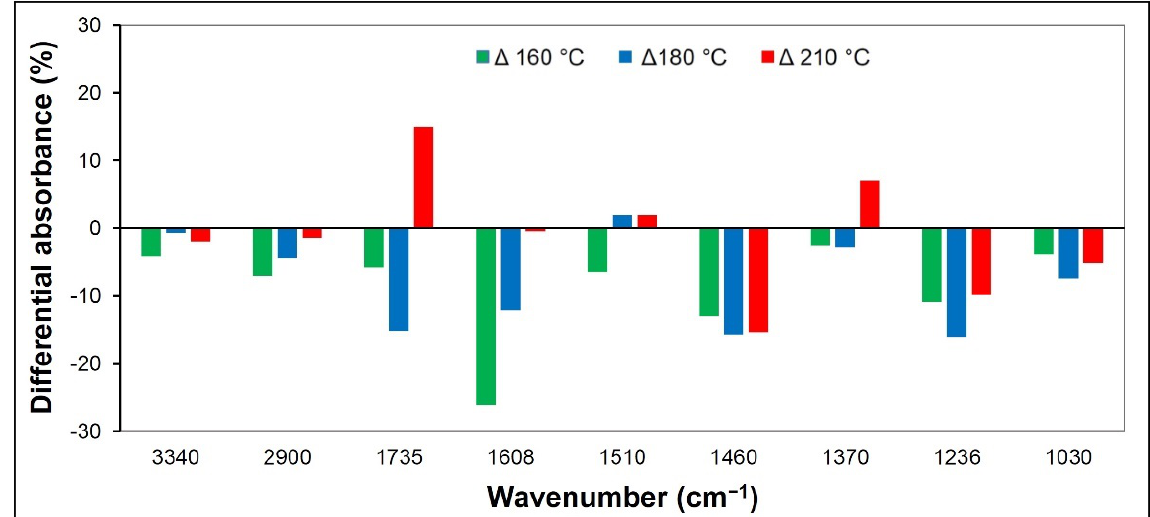
Figure 6. Differential FTIR spectra of untreated and thermally treated black locust wood.